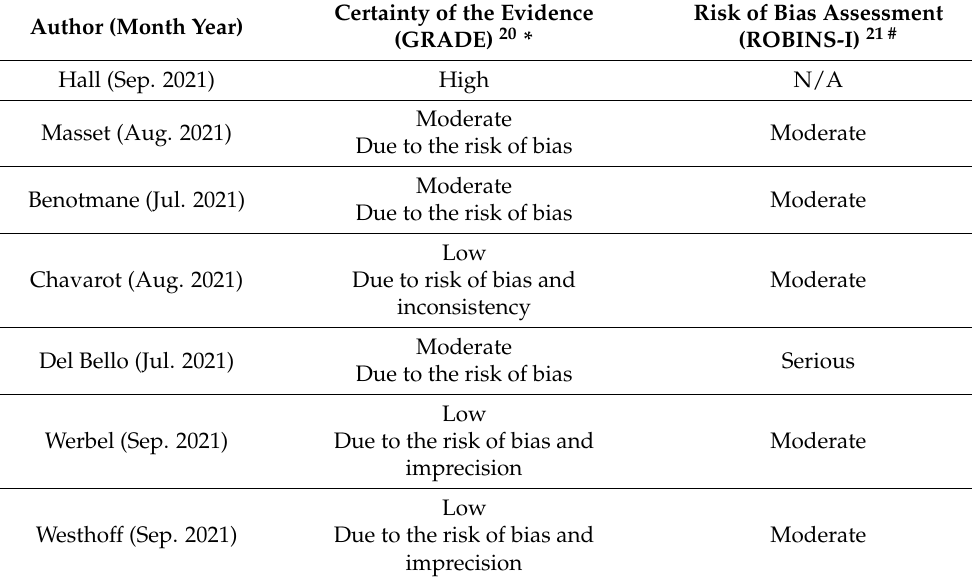
Table 3. Quality assessments of included